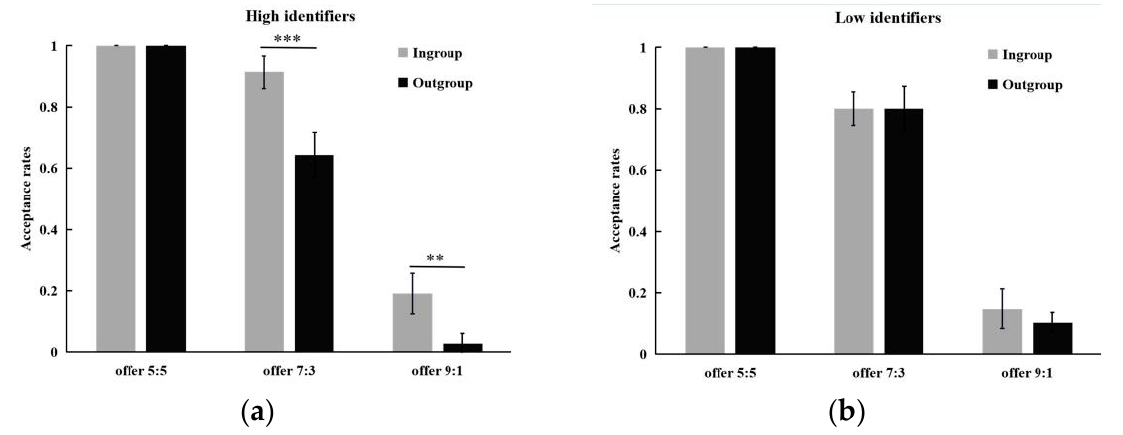
Figure 1. Results from Study 1. Averaged acceptance rates of different proposal as a function of group affiliation for ( a ) high identifiers and ( b ) low identifiers. Error bars indicate standard error. ** p < 0.01, *** p < 0.001.